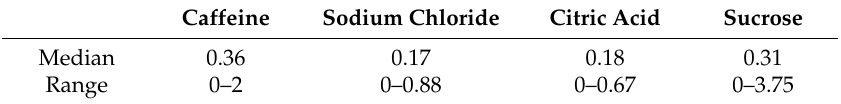
Figure 1. Ratings of intensity on the generalized Labeled Magnitude Scale for each stimulus, by low (circle) and high (diamond) concentration. Table 1. Summary of low-to-high taste intensity (generalized Labeled Magnitude Scale) ratios.